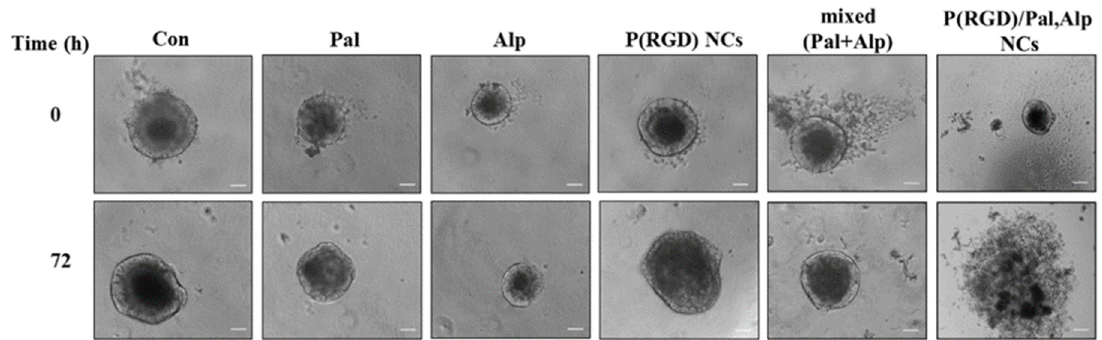
Figure 10. Bright-field microscopic images of patient-derived xenograft (PDX) colon tumor cells after exposure to Pal, Alp, Pal + Alp and hollow and drug loaded P(RGD) NCs. Spheroids were incubated for 72 h. 10× magnification, scale bar = 102 µm.